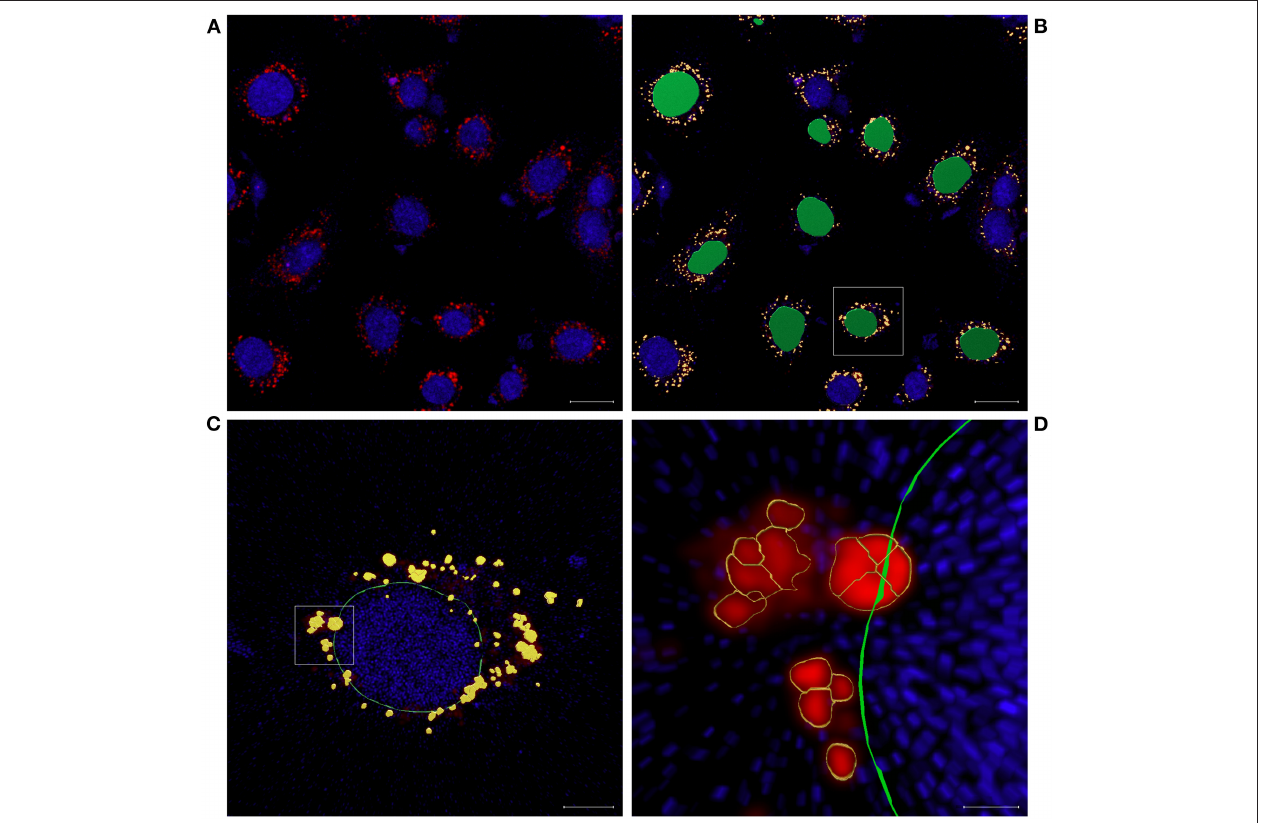
FIGURE 3 | BFH12 treated with 100 µ M oleic acid. (A) All labeled cells in one of the defined areas on the flow chamber, nuclei stained with DAPI (blue), and lipid droplets (LD) stained with LipidSpot 610 (red). (B) same image as (A) with nuclei surfaces (green) and LD surfaces (yellow) as they are present after image segmentation and nuclei that do not meet criteria for analyses (blue). (C) Enlargement of (B); nucleus is marked with a green outline for better contrast to quantified LD surfaces (yellow). (D) Enlargement of (C); irregular-shaped LDs and cluster of small LDs; nucleus is marked with a green outline, and LDs are marked with yellow outline; scale bar: (A) and (B) = 20 µ m; (C) = 5 µ m; (D) = 1 µ